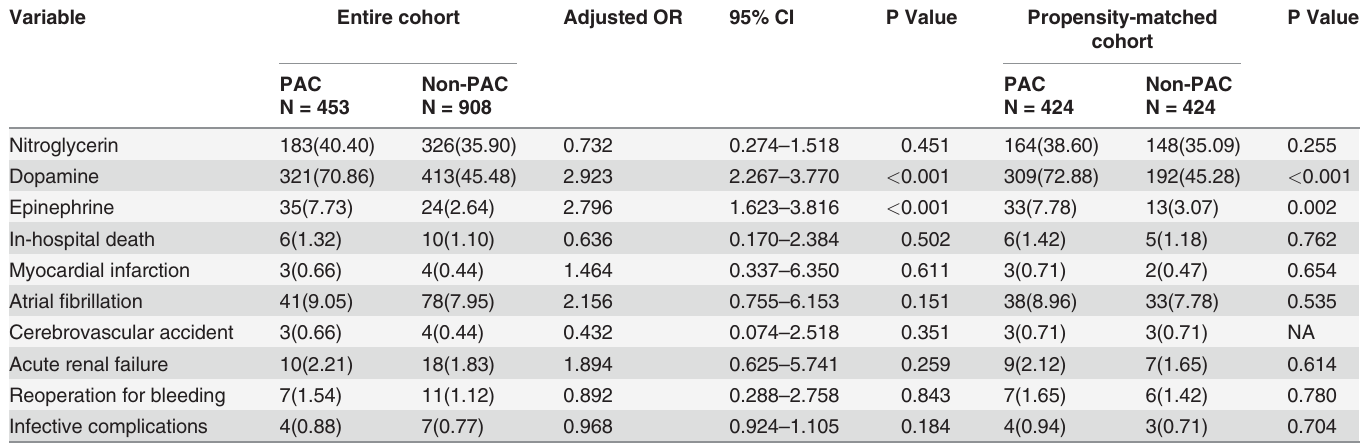
Table 2. Intraoperative Vasoactive Drugs and Postoperative